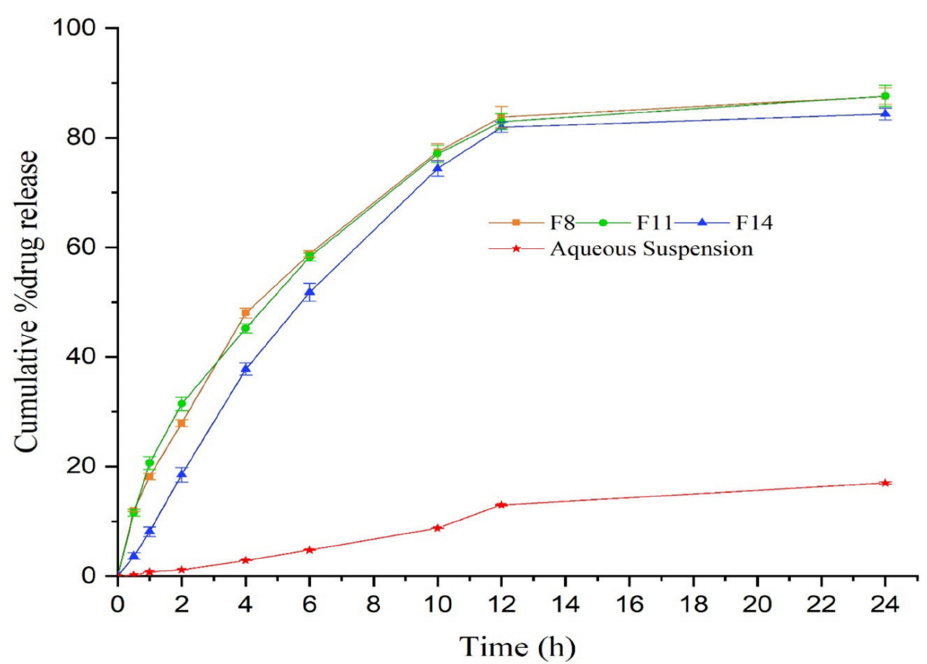
Figure 4. In vitro release of thymoquinone from nanoformulations differing in composition (F8, F11, and F14) vs. the aqueous suspension of thymoquinone carried out through the dialysis bag technique. Reproduced from [45], Copyright 2021, MDPI.